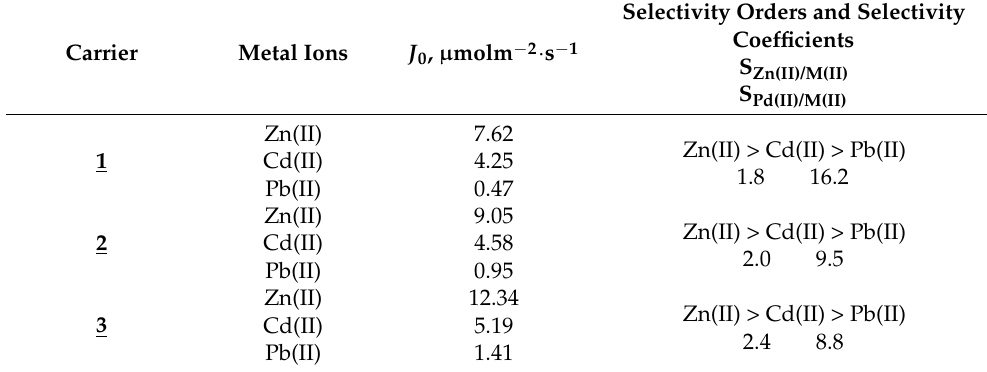
Table 5. Initial fluxes, selectivity order and selectivity coefficients for competitive transport of Pb(II), Zn(II), and Cd(II) ions across PIMs with 1-alkyl-1,2,4-triazole ( 1 – 3 ), membrane: 45% o-NPPE, 30% CTA, and 25% of 1-alkyltriazole 1 – 3 .; feed phase: 0.001 M each metal ion, pH = 4.0; receiving phase: 0.01 M